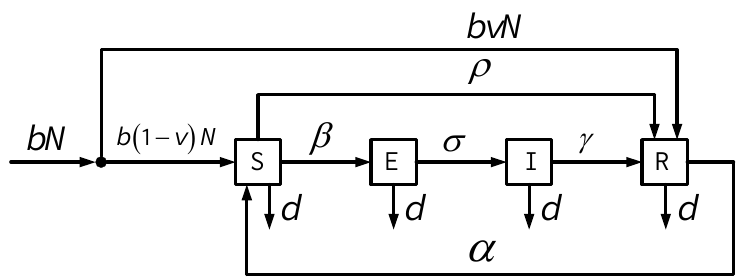
Figure 1. SEIRS Model with Vital Dynamics and Vaccinations.